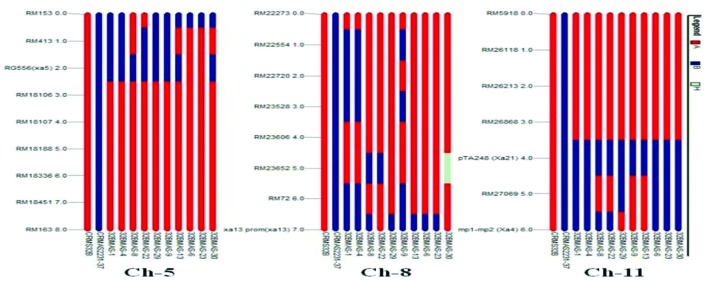
Graphical genotype analysis of genome introgression associated with BB resistance genes xa5 (chr 5), xal3 (chr 8), Xa4 and Xa21 (chr 11) in the background of in the gene pyramids of CRMS 32B in BC3F3 generation.